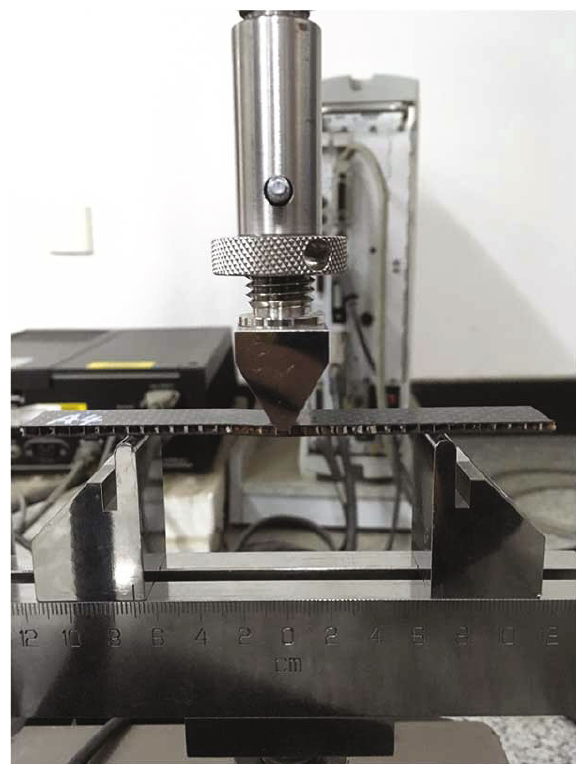
Figure 12: INSTRON-5848 microforce material testing machine.